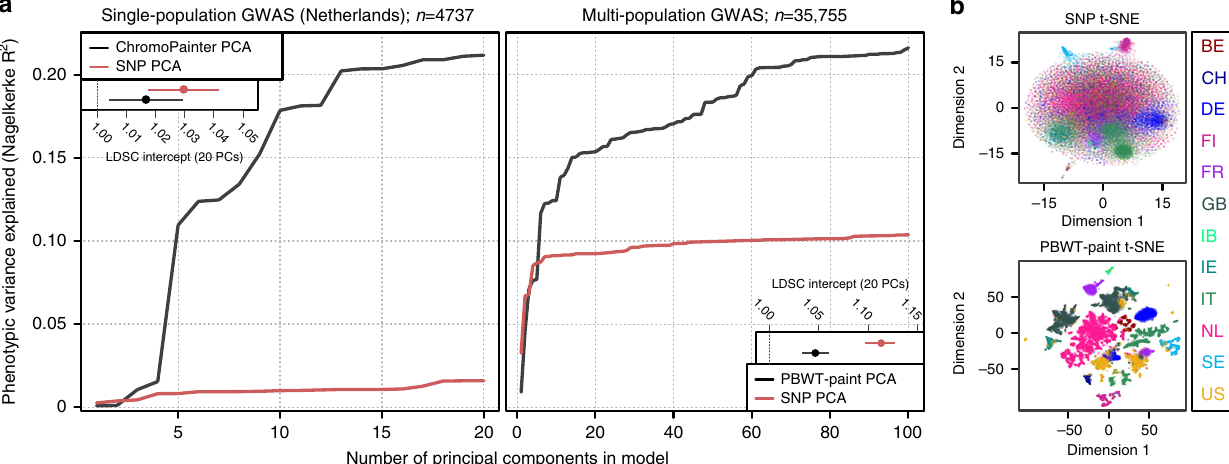
Fig. 6 Fine-grained population structure and genome-wide association study (GWAS) confounding. a Variance in phenotype (amyotrophic lateral sclerosis) explained by principal components (PCs) for a single-population Dutch GWAS (left) and a multi-population GWAS (right). Insets show linkage disequilibrium score regression (LDSC) intercept terms (a summary estimate of GWAS confounding) when the fi rst 20 single nucleotide polymorphism (SNP)-based PCs (SNP PCA) or the fi rst 20 haplotype-based PCs (ChromoPainter/PBWT-paint PCA) are included as GWAS covariates. b Summary visualisations (t-distributed stochastic neighbour embedding, t-SNE) of local and global structure in the multi-population GWAS based on SNP genotypes (top) or haplotype sharing inferred using the scalable PBWT-paint chromosome painting algorithm (bottom). Individuals are coloured by country of origin; labels (right) follow ISO 3166-1 country codes, except IB, which was labelled Iberia (containing Spanish and Portuguese data) in the original GWAS dataset. PCA, principal component analysis; PBWT, positional Burrows-Wheeler